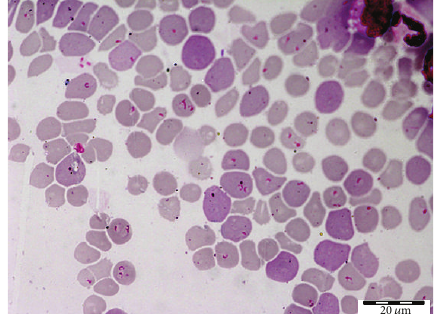
Figure 1: Photomicrograph of Giemsa-stained thin blood smear of the dog showing regenerative anemia and small circular shaped trophozoites of Babesia gibsoni in erythrocytes ×